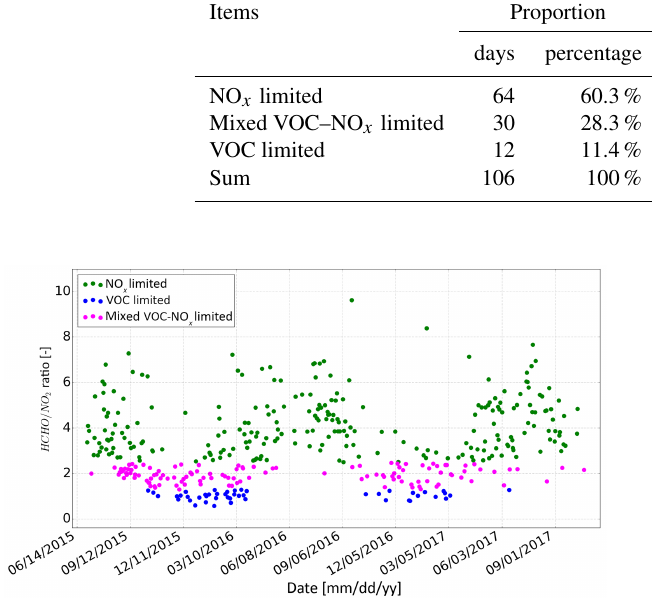
Figure 7. Time series of column HCHO / NO 2